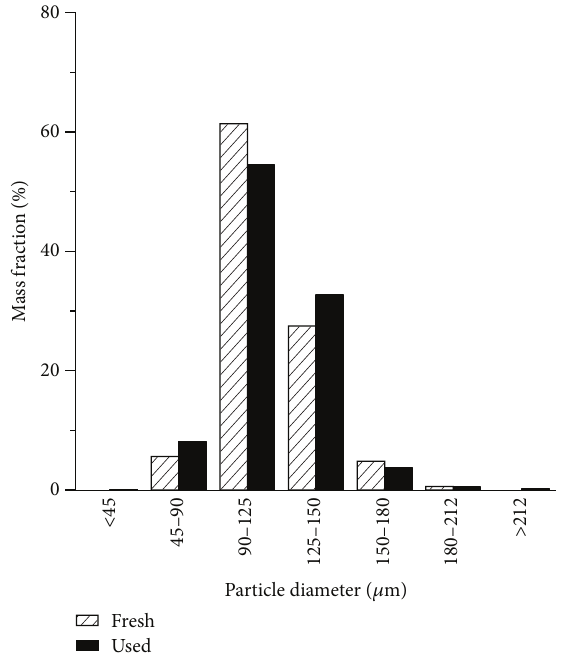
Figure 8: CO 2 yield as a function of degree of reduction. Results from reduction with methane inquartz batch reactor. Fresh particles are compared with materials used in the 300 W unit. These results are performed at 950 ∘ C.